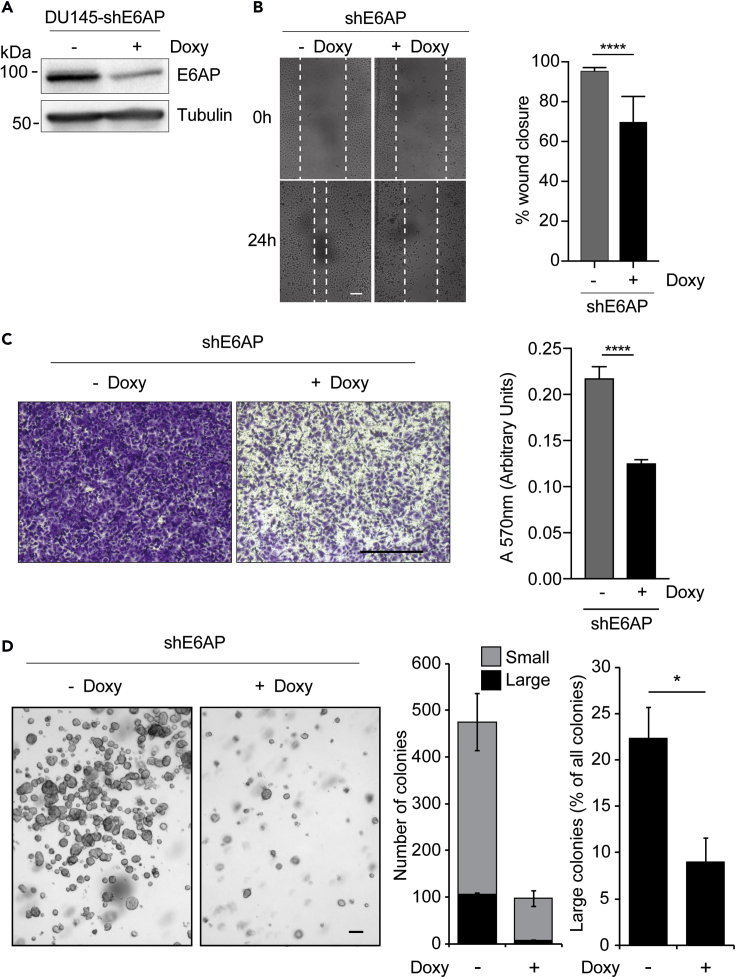
E6AP Knockdown Reduces the Metastatic Potential of PC Cells In Vitro(A) Immunoblot confirming KD of E6AP upon Doxy treatment for three days in DU145-shE6AP cells.(B and C) (B) DU145-shE6AP cells were treated with Doxy for three days before the confluent cell monolayer was scratched. Cells were then allowed to migrate in the presence or absence of Doxy for 24 h. Representative images are shown on the left panels and quantification of wound closure was calculated from triplicates and was obtained from multiple photographed fields taken immediately following the scratch and at the endpoint (right panel). Quantification of a representative experiment is shown as mean ± SD. ****p < 0.0001, unpaired t test. Scale bar represents 100 μm. (C) DU145-shE6AP cells were treated with Doxy for 2.5 days, seeded in transwells, and allowed to migrate in the presence or absence of Doxy for 24 h. Invaded cells were stained with crystal violet (left) and quantified at A570 after extraction of the dye (right). Each experiment was performed in duplicates and repeated three independent times. Quantification of a representative experiment is shown as mean ± SD. Scale bar represents 500μm.(D) DU145-shE6AP cells were grown in soft agar in the presence or absence of Doxy for 11 days. Fresh Doxy was added every three days. Representative images at experimental endpoint are shown. Quantification was based on duplicate experiments and unbiased computational detection and enumeration of colony size into small and large sizes using imaging software (large: >1,000 pixels, small 10–1,000 pixels). Large-size colony percentages were calculated as a proportion of total cells and/or colonies in each magnification field. Scale bar represents 100μm. ****p < 0.0001, unpaired t test.